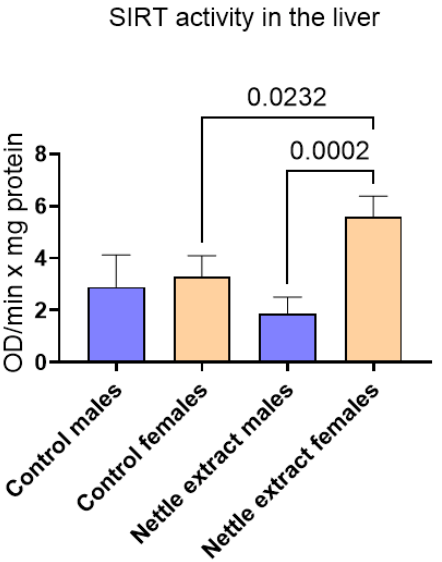
Figure 3. The changes in SIRT1 activity in the liver of C57Bl6 mice treated with nettle extract. The numbers above bars are p values meaning statistically significant ( p ≤ 0.05) differences between the treated groups by Kruskal–Wallis ANOVA.